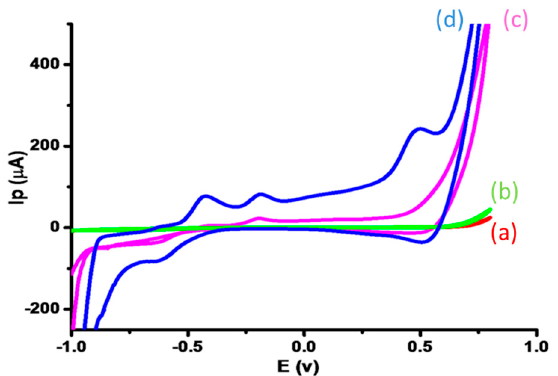
Figure 3. Cyclic voltammograms recorded in 0.1 M NaOH in either ( a ) the absence of glucose or ( b ) the presence of 1 mM glucose with a bare GCE; and CuO-nanostructure-modified GCEs in either ( c ) the absence of glucose or ( d ) the presence of 1 mM glucose. Scan rates are 0.05 mV·s − 1 .